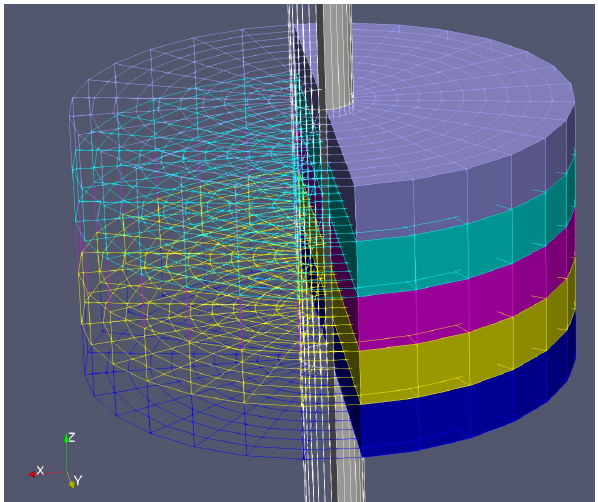
Figure 9. Mesh of the SIRIUS-CAL